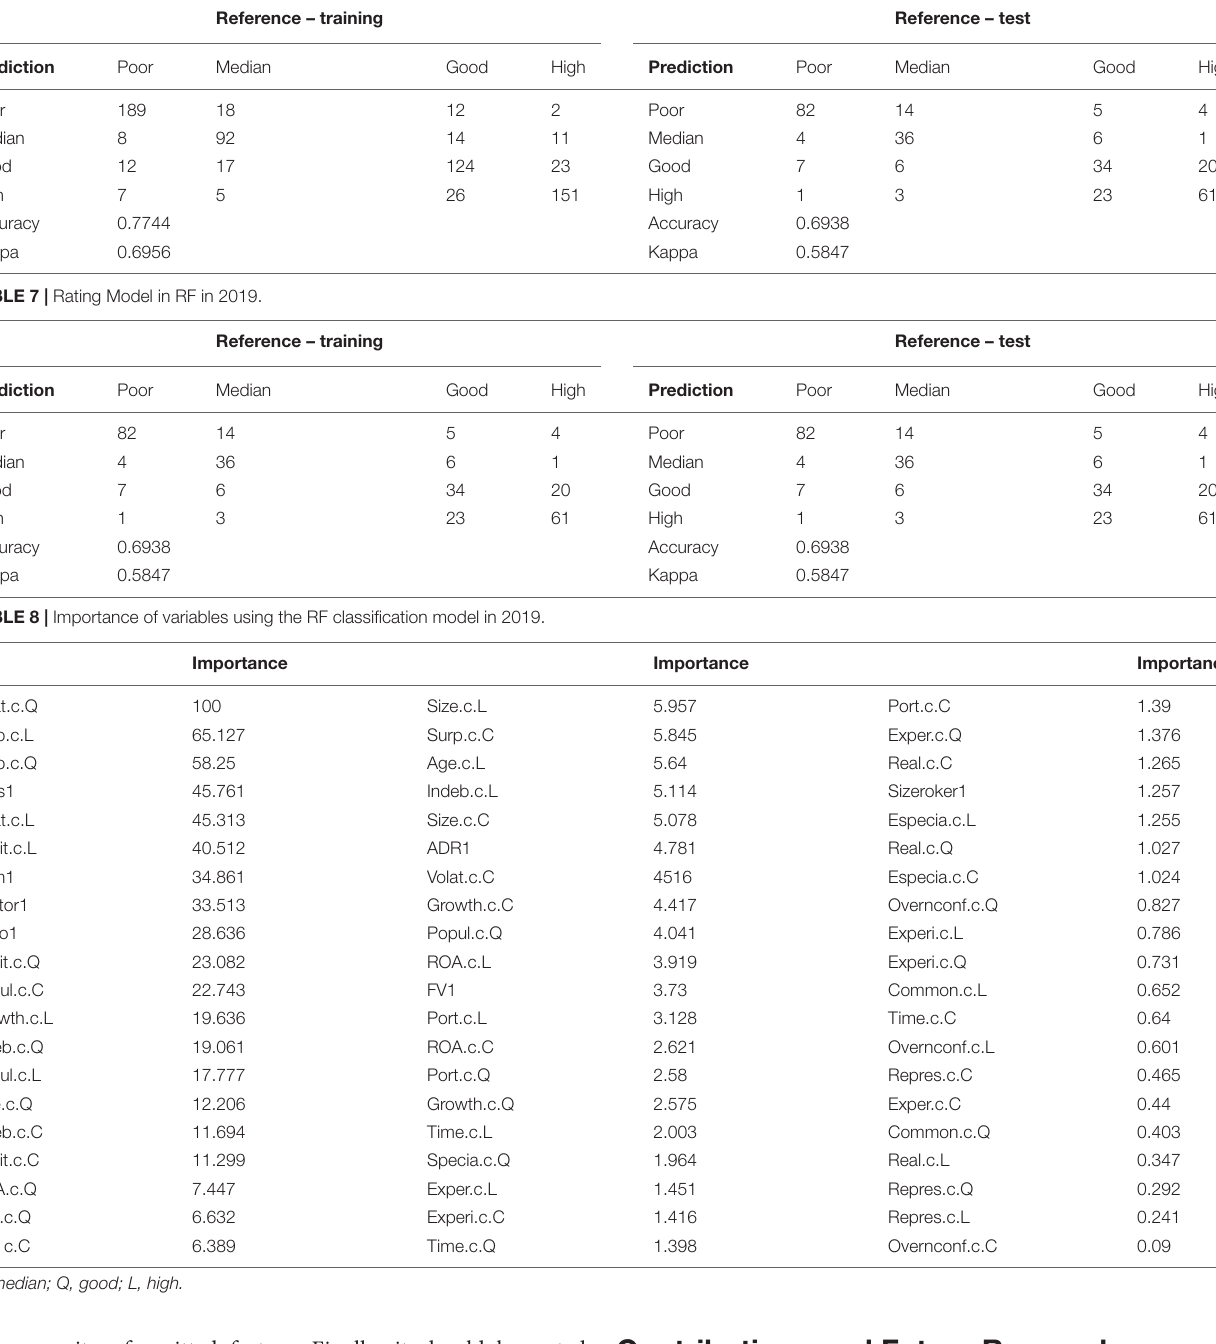
TABLE 6 | Confusion matrix for the k -dependence Bayesian ( k -DB) classification model in 2019.